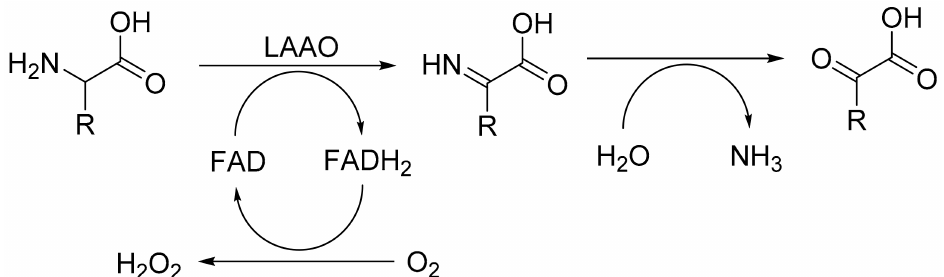
Figure 1. The catalytic mechanism of LAAO: oxidation of amino acids into imino acids and the subsequent reoxidation of the FAD cofactor by reduction of dioxygen into hydrogen peroxide. The hydration of the initial product, imino acid, is a spontaneous